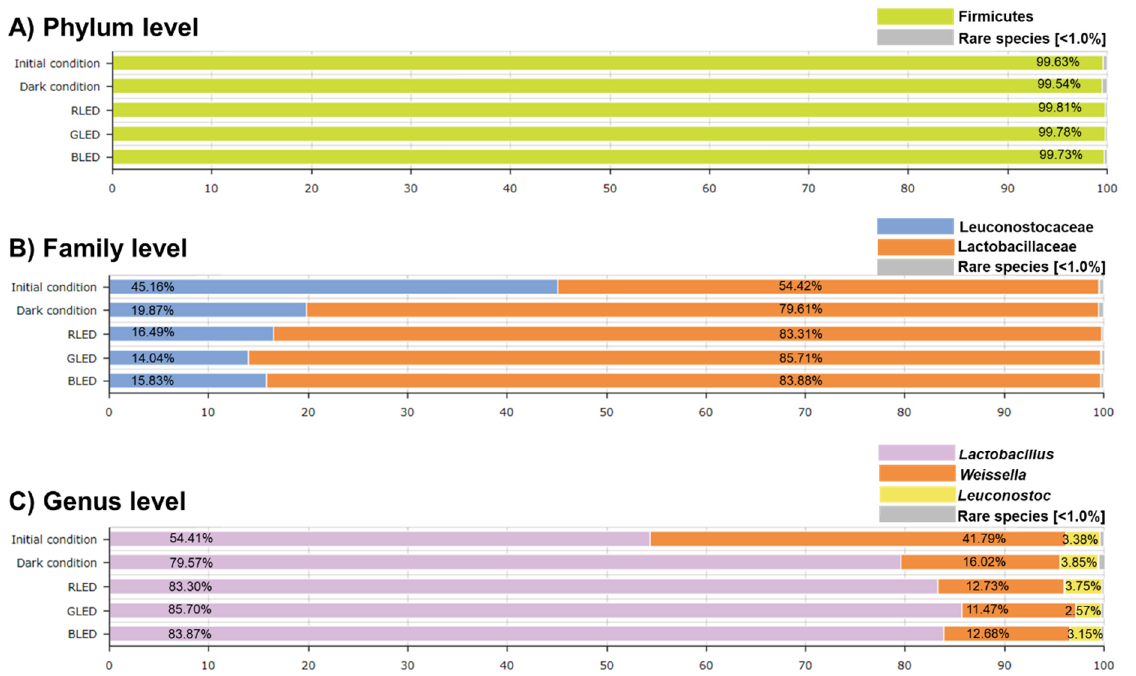
Figure 1. Characteristic changes in microbial taxonomic composition by LED-irradiation at the phylum ( A ), family ( B ), and genus levels ( C ). Firmicutes are the major phylum in all conditions. Leuconostocaceae and Lactobacillaceae are the major family, while Lactobacillus , Weissella , and Leuconostoc are the most dominant genus. Rare species were defined as species found at a frequency of <1% in each sample.